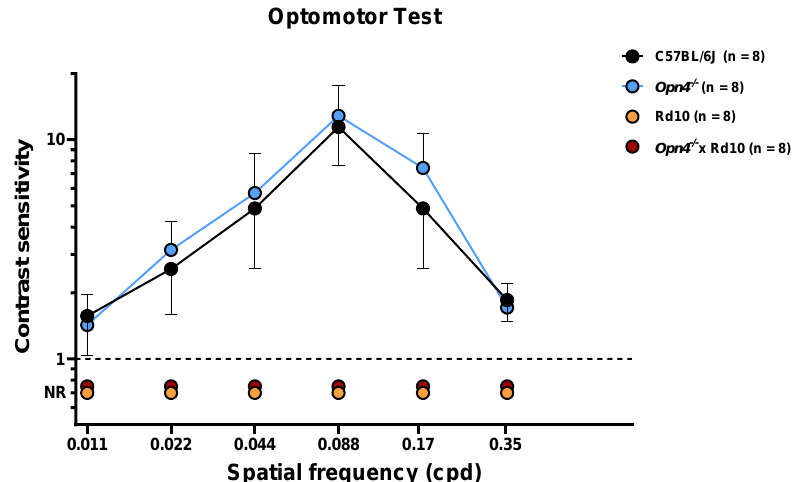
Figure 2. Evaluation of visual acuity of the different animal models using the optomotor test. (C57BL/6J (●), n = 8; Opn4 −/− ( ● ), n = 8; Rd10 ( ● ), n = 8; Opn4 −/− × Rd10 ( ● ), n = 8). While the Opn4 −/− animal model did not show any difference in contrast sensitivity compared to the control model, the animal models that presented photoreceptor degeneration (Rd10 and Opn4 −/− × Rd10) were not able to respond to any presented stimulus ( p < 0,001). Data are presented as mean ± SD. The sensitivity of these animals is maximum for a spatial frequency of 0.008 cpd and decreases progressively and symmetrically as the spatial frequency increases or decreases.